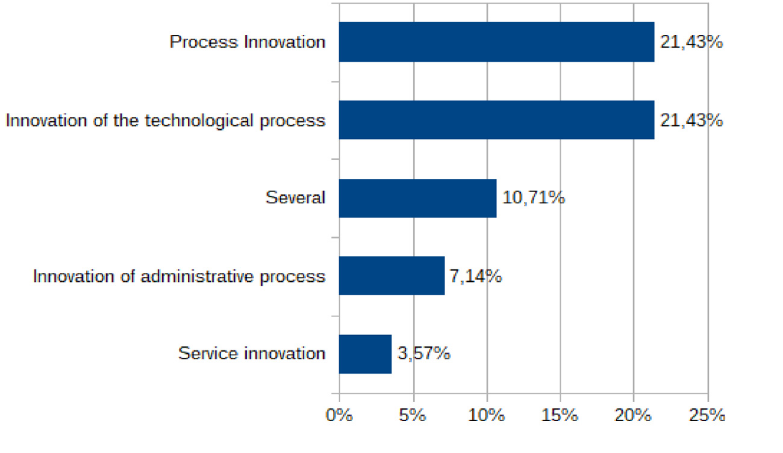
Figure 5. Type of innovation